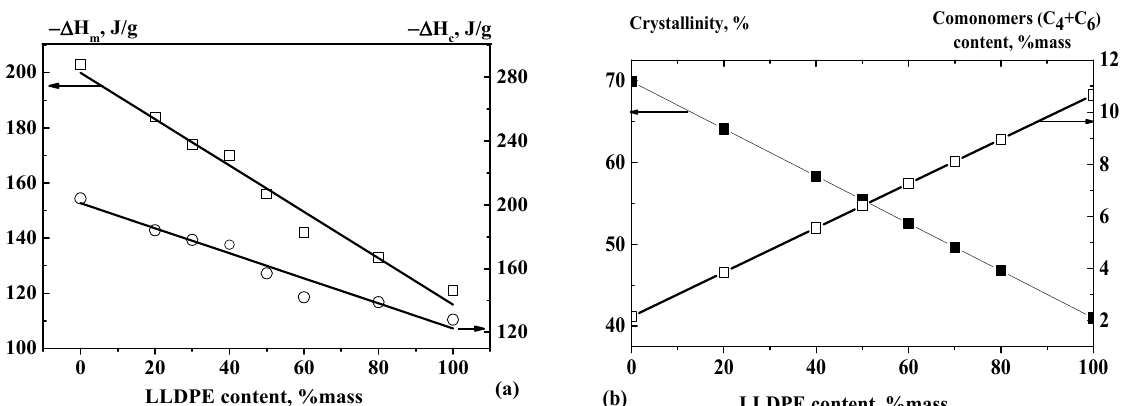
Figure 2. ( a ) Effect of LLDPE content on melting heat and crystallization heat. ( b ) Effect of LLDPE content on crystallinity and co-monomer content (butene-1 and hexene-1) in the macromolecule structure of HDPE/LLDPE binary mixtures.